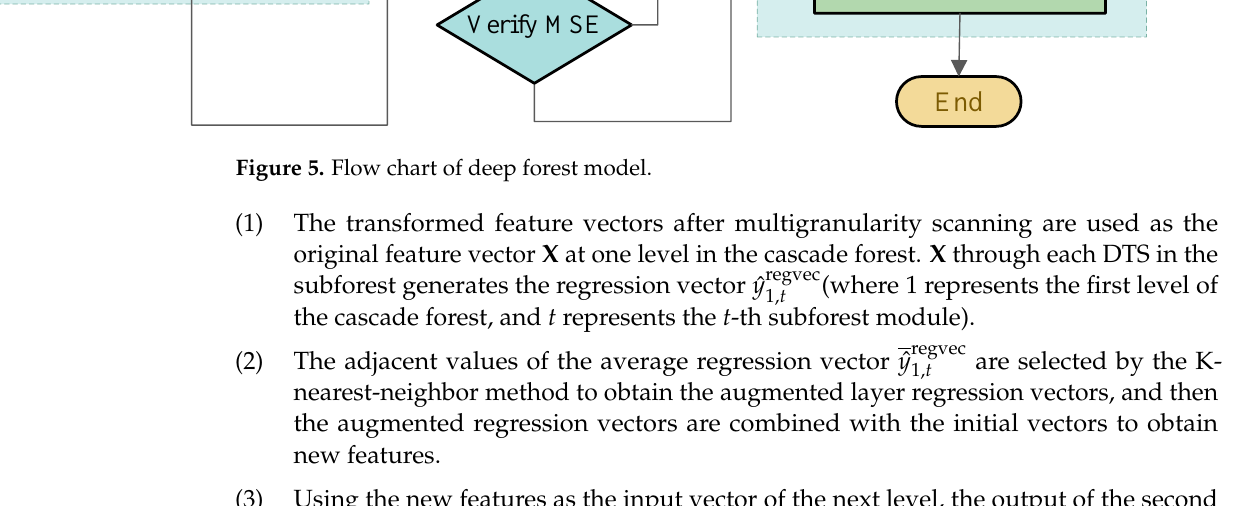
regvec ˆ y (where 1 represents the first level of 1, t